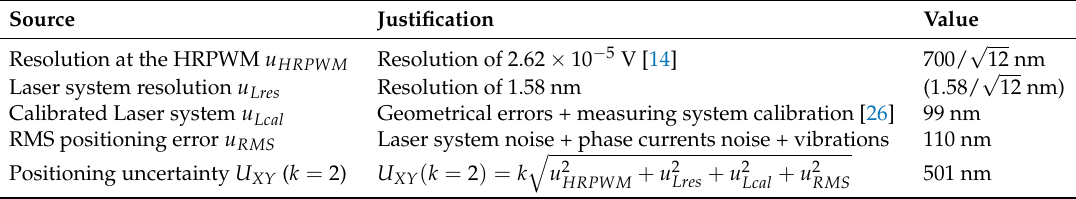
Table 2. NanoPla positioning uncertainty contributors and